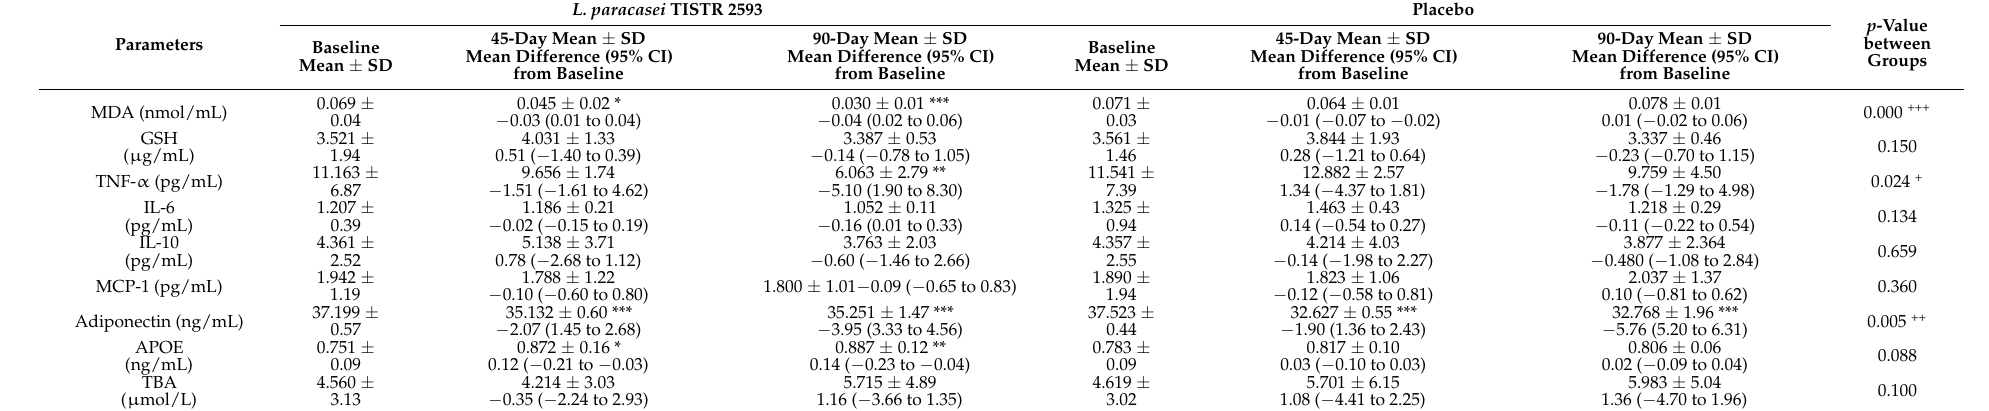
Table 4. Effect of L. paracasei TISTR 2593 supplement on adiponectin, apolipoprotein E, and total bile acid